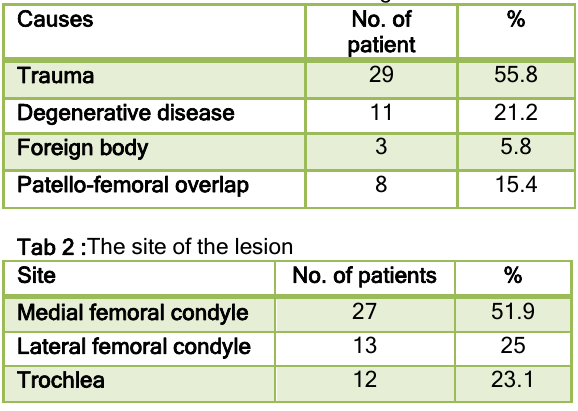
Tab 1 : The causes of aricular cartilage insult